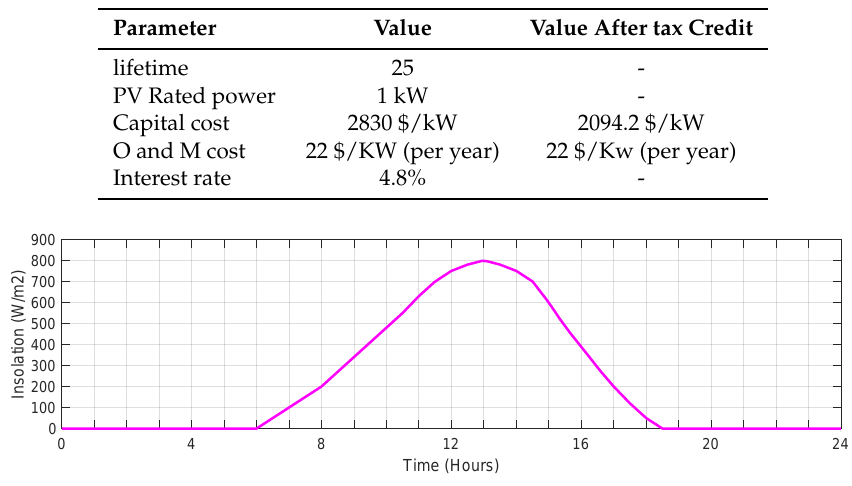
Table 2. PV parameters.